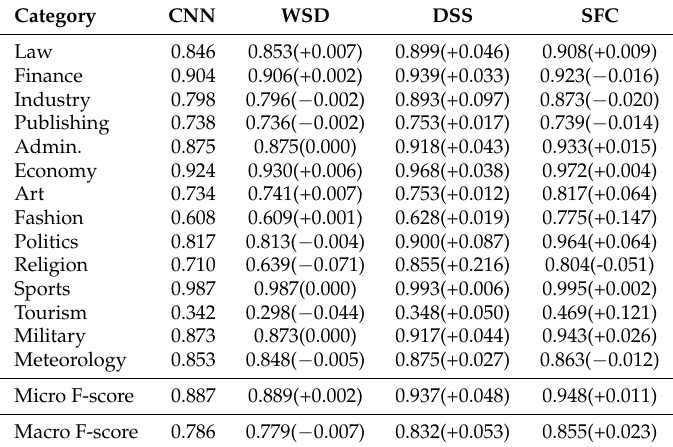
Table 5. Classification performance (Topmost